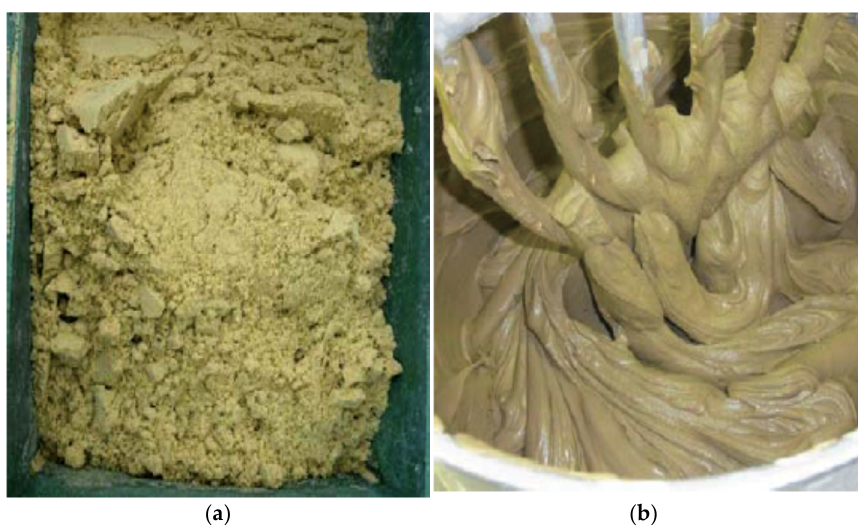
Figure 1. Grain size addition curve of target soils.